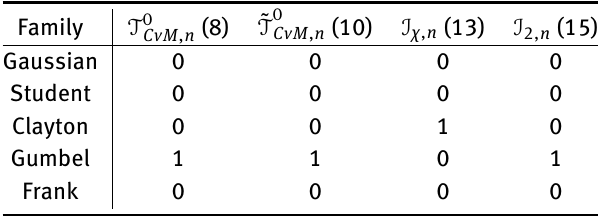
Table 1: Rejection percentages under the null (nonparametric tests, nonparametric bootstrap bootNP).